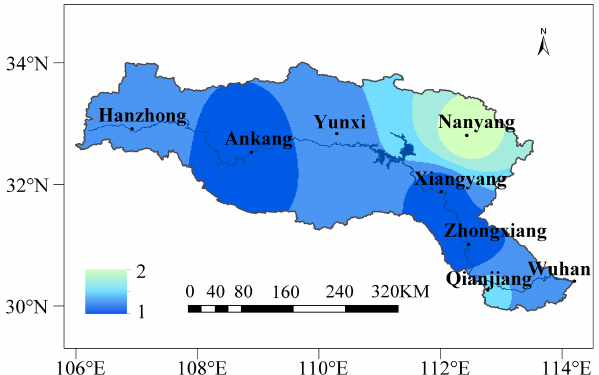
Figure 7. Distribution of average flood grades for each site corre- sponding to the severest flood years in each century. The color bar indicates the grade of drought and